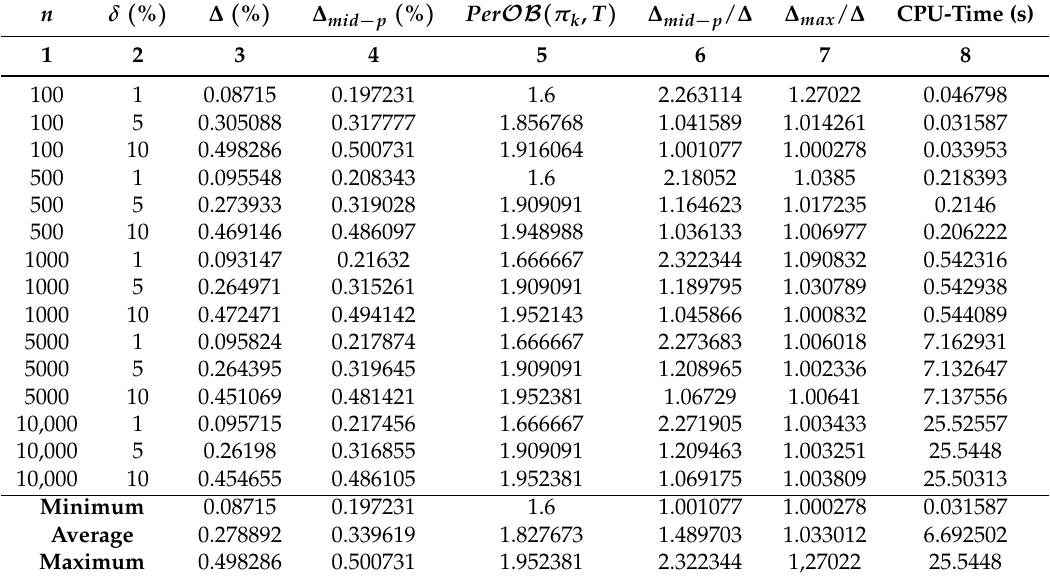
Table 2. Computational results for randomly generated instances with a single block (class